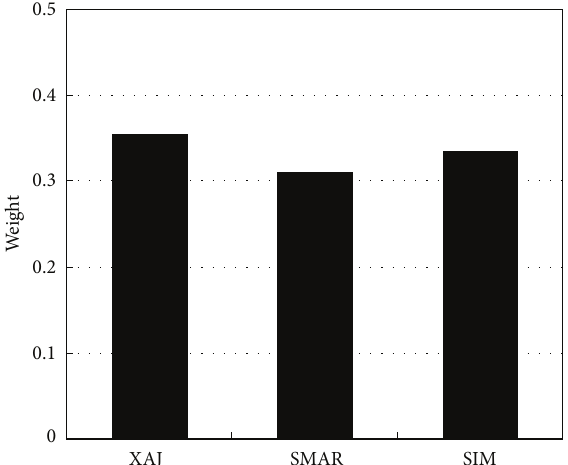
Figure 4: Histogram of weights of individual model predictions in BMA(3) scheme.